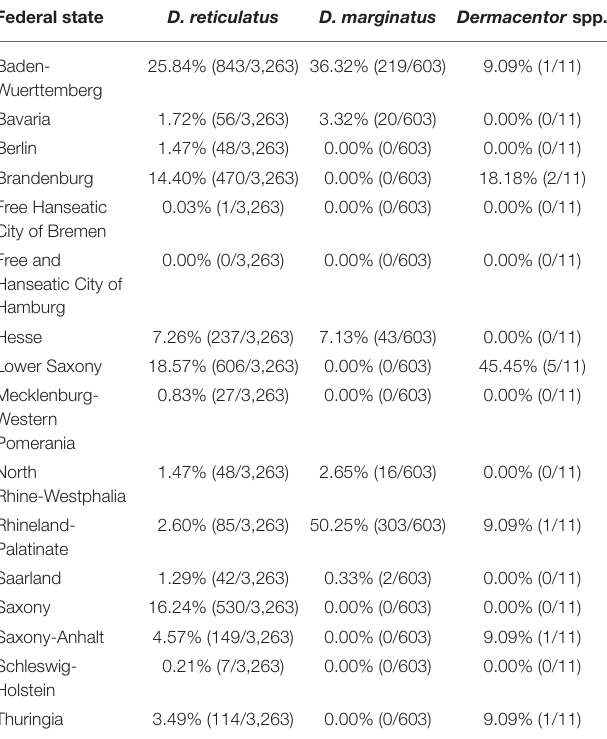
TABLE 1 | Distribution of the 3,263 Dermacentor reticulatus , 603 Dermacentor marginatus , and 11 unidentified Dermacentor specimens of unambiguous origin among the federal states of